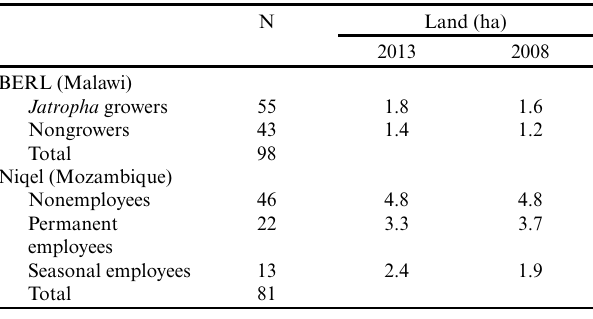
Table 6 . Changes in agricultural land between 2008 and